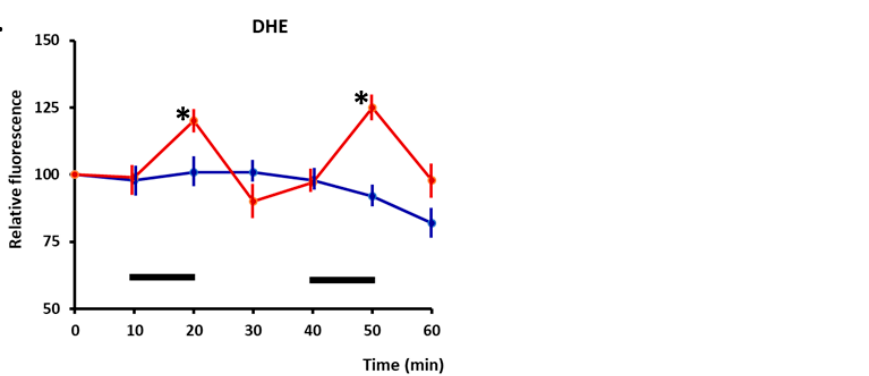
Figure 1. ( A ). Time course of changes in relative fluorescence from skeletal muscle fibres loaded with MitoSox red (localised to mitochondria). Fibres were either maintained at rest (blue line) or subjected to two periods of electrically stimulated contractions (red line) during the time periods denoted by a black bar. ( B ). Fibres loaded with DHE (localizes to cytosol): time course of changes in relative fluorescence is shown. Fibres were either maintained at rest or subjected to two periods of electrically stimulated contractions, with the stimulation periods denoted by black bars. * p < 0.05 compared with non-stimulated fibres at the same time point ( n = 6–7 for all groups). Redrawn from [32], where full experimental details can be found.